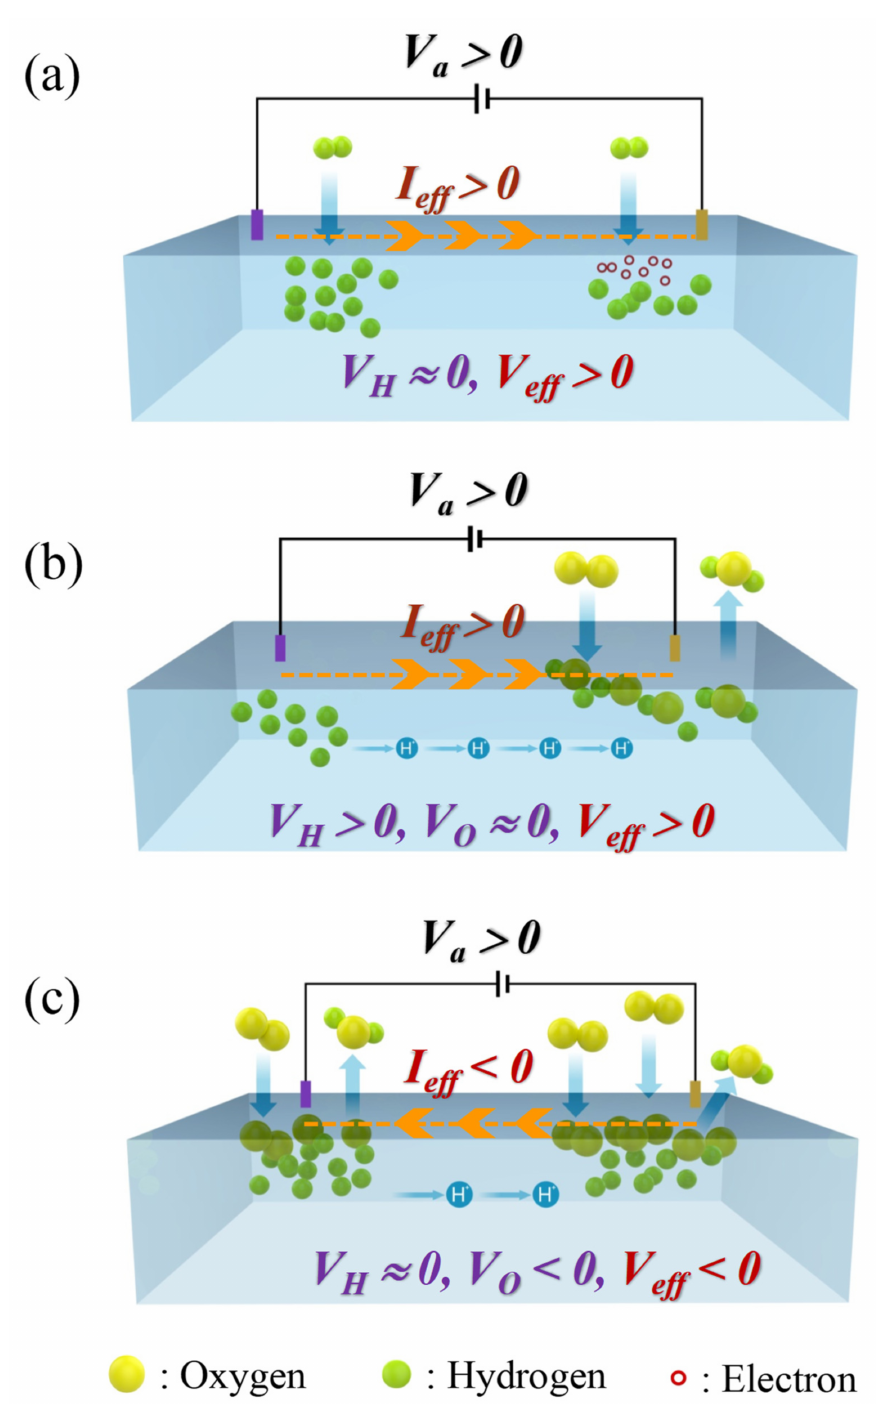
Figure 5. ( a ) PBCC thin film under the reducing gas, H 2 gas. ( b ) Reduced PBCC thin film under O 2 gas at temperatures below 600 ◦ C. ( c ) Reduced PBCC thin film under O 2 gas at temperatures above 600 ◦